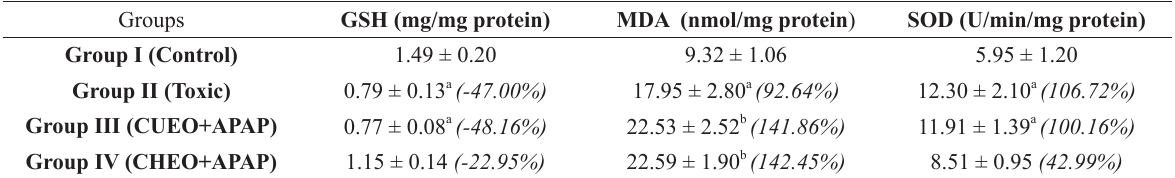
Effects of repeated administration of CUEO or CHEO on key markers of oxidative stress in the rat liver after acute APAP toxicity.